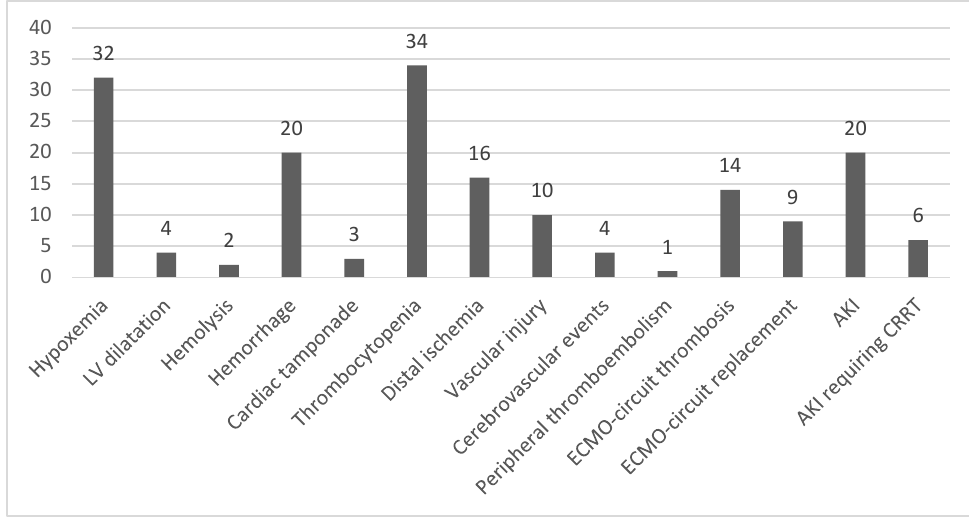
Figure 1. Noninfectious complications occurring during extracorporeal membrane oxygenation.